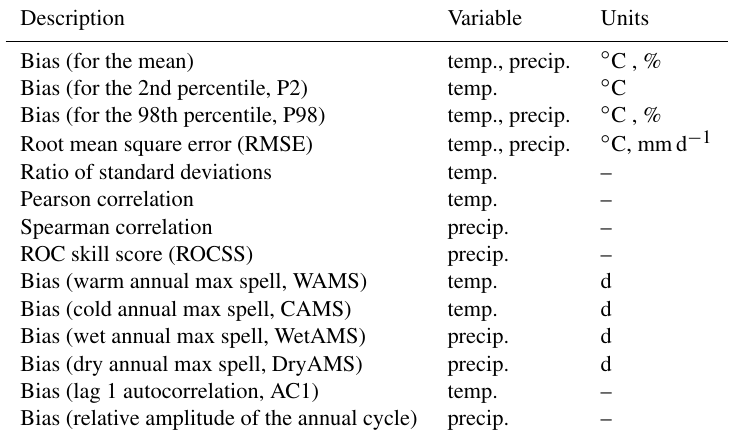
Table 1. Subset of VALUE metrics used in this study to validate the different downscaling methods considered (see Table 2). The symbol “–” denotes